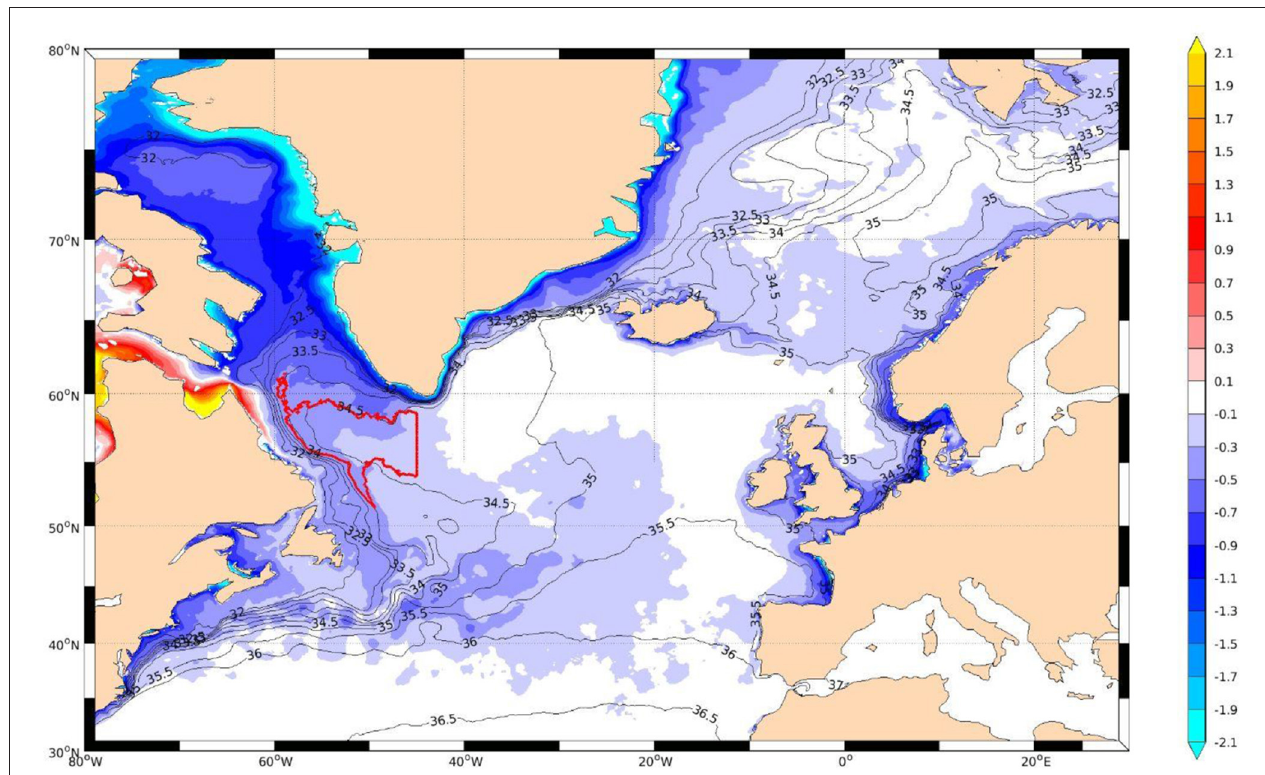
FIGURE 2 | SSS anomalies (melting minus control experiments) averaged over years 2004–2016 in HR expressed in PSU. The mean state of the control simulation averaged over the same period is shown in contour. The red line stands for the definition of the Labrador Sea convection site (defined as the region where the MLD is larger than 600m at least during 1 month in the control